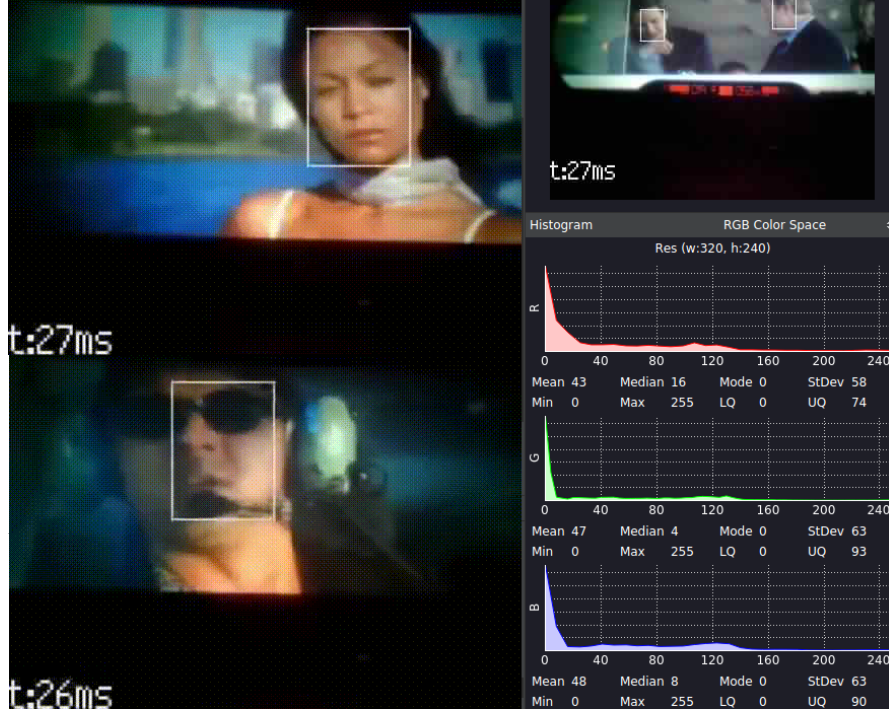
Figure 1. K210 face detection inference demo.